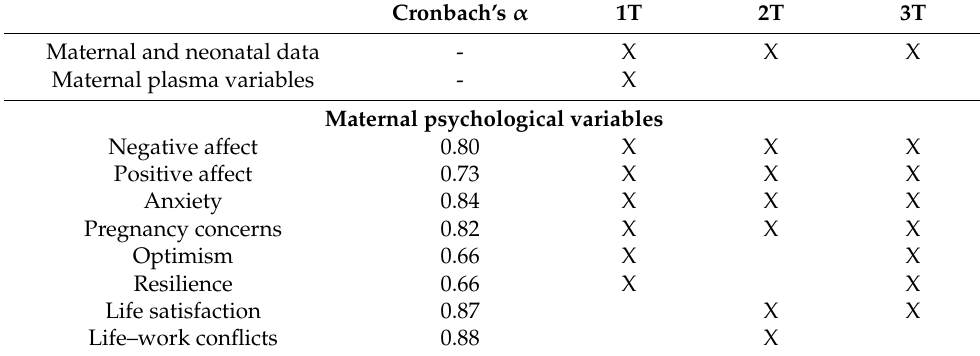
Table 1. Timing for data collection and reliability of the psychological application. Cronbach’s α 1T 2T 3T Maternal and neonatal data - X X X Maternal plasma variables